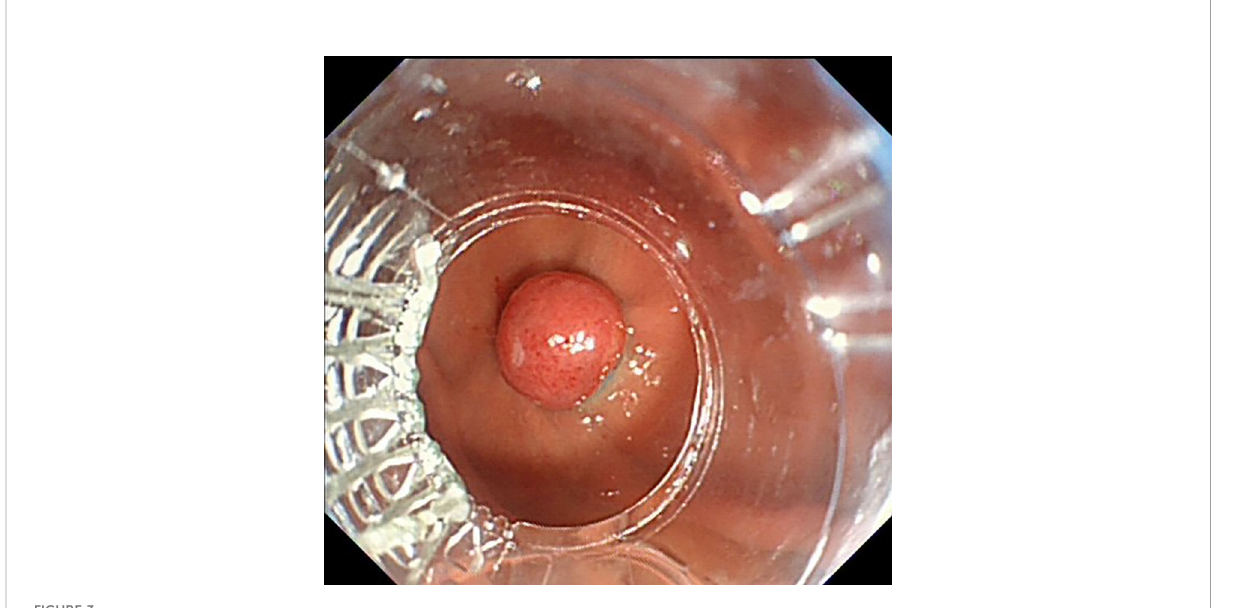
FIGURE 3 Nodular lymphangioma in the gastric fundus.